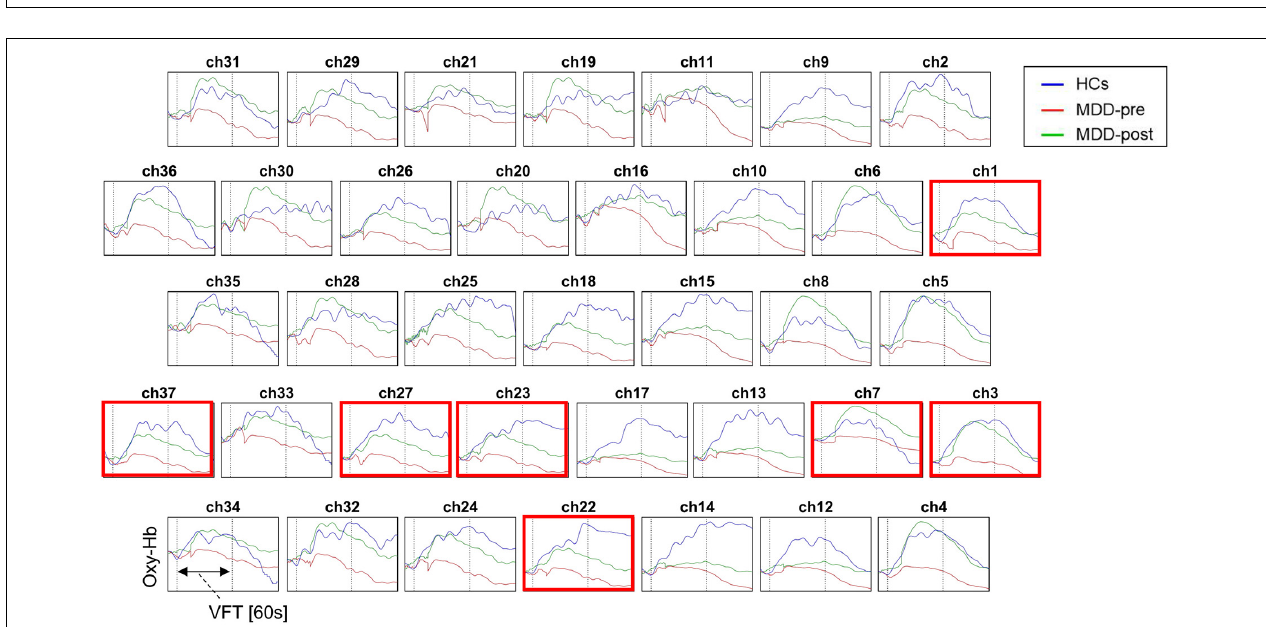
FIGURE 3 | Prefrontal cortical activation during the VFT in patients with MDD before (pre) and after (post) rTMS treatment and HCs. The color scale depicts the change of [oxy-Hb] value range from − 0.3 to 0.3 in µ mol × mm.